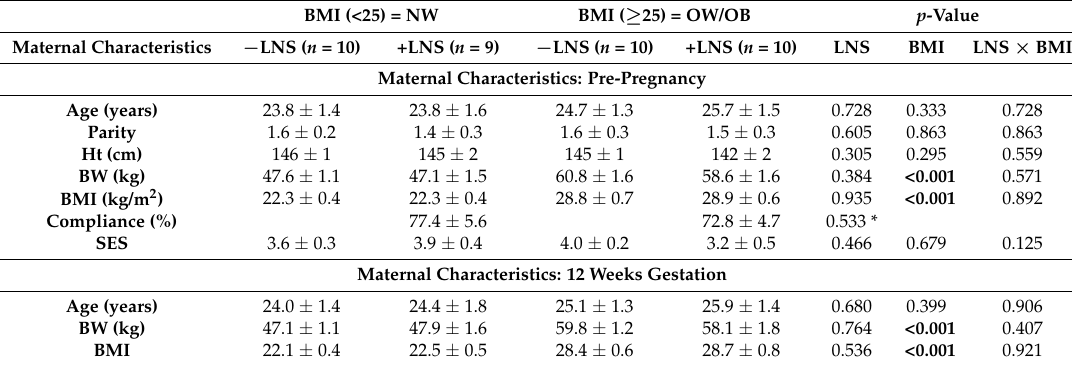
Table 1. Maternal characteristics prior to pregnancy and 12 weeks